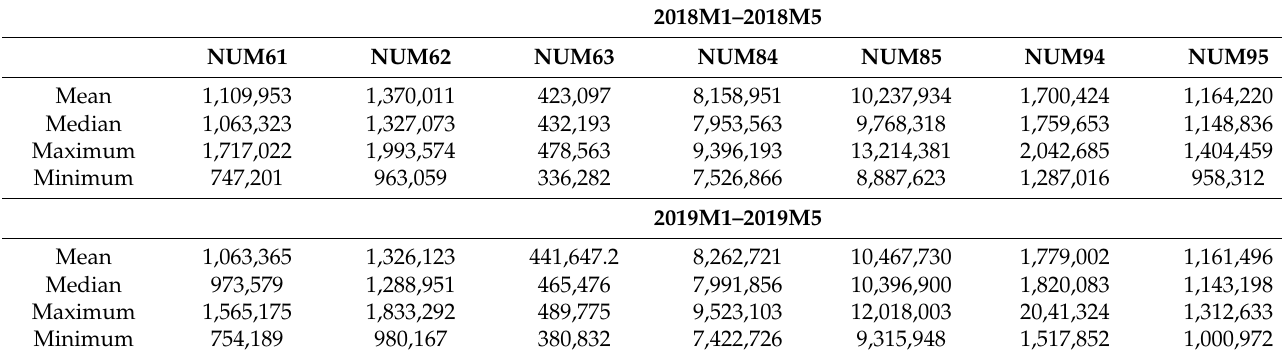
Table A2. Comparison of the first five months of exports.